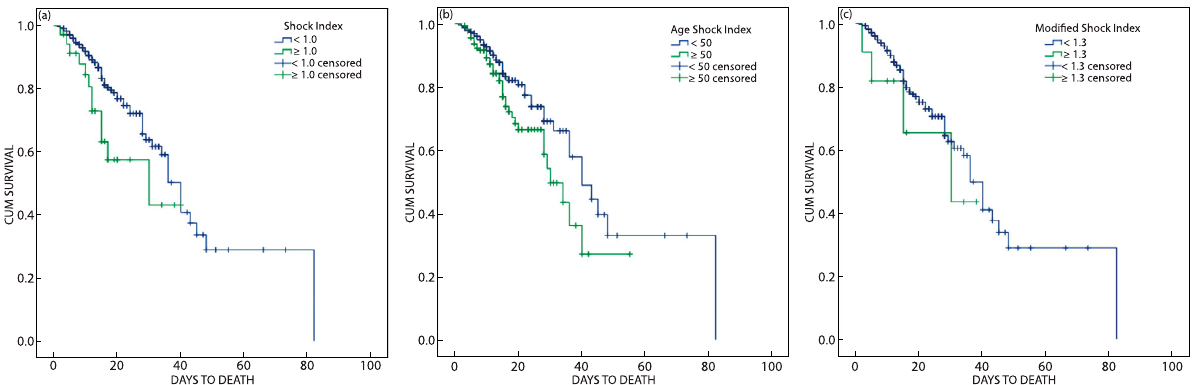
Figure 1: (a) The survival function of hospitalisation by shock index; (b) The survival function of hospitalisation by age shock index (age SI); (c) The survival function of hospitalisation by modi fi ed shock index